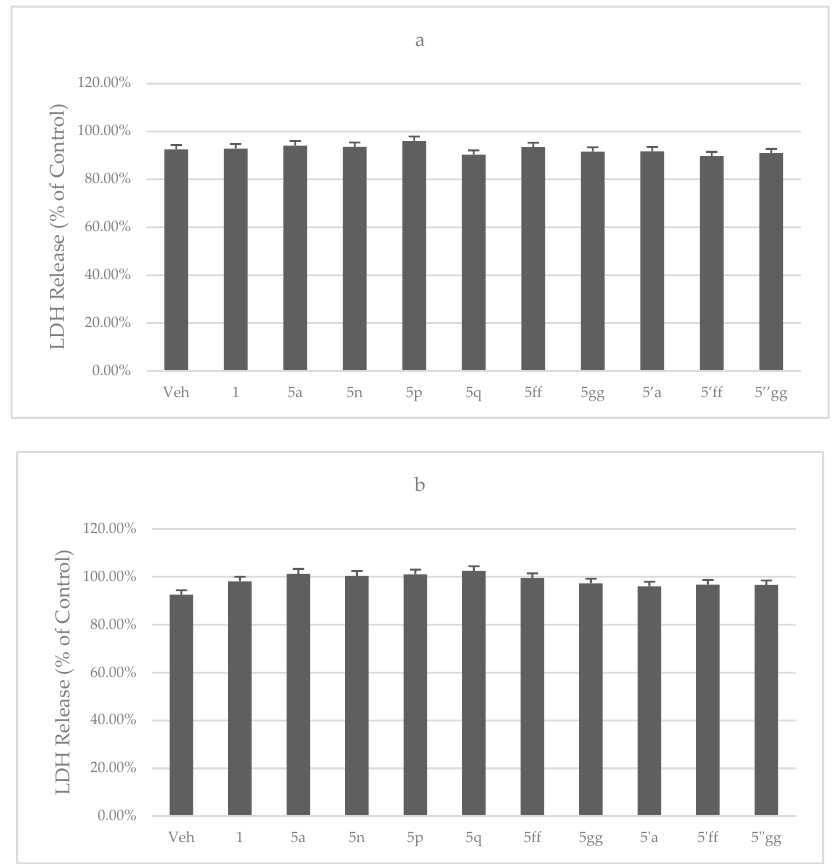
Figure 5. Cytotoxicity of some of ginkgolide-1,2,3-triazole derivatives: ( a ) Tested at 1 µ M concentration. ( b ) Tested at 10 µ M concentration. Ginkgolide B ( 1 ) was used as reference.